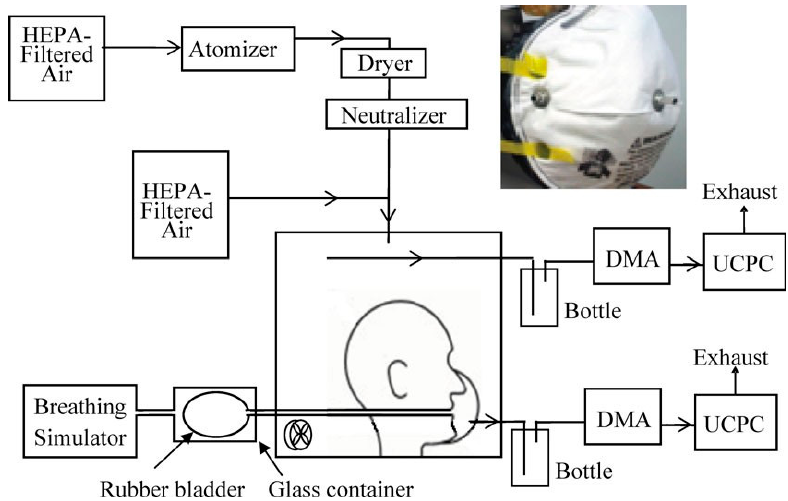
Figure 15. Experimental set ‐ up for testing and evaluation of submicron ‐ sized bioaerosols leakage [62].